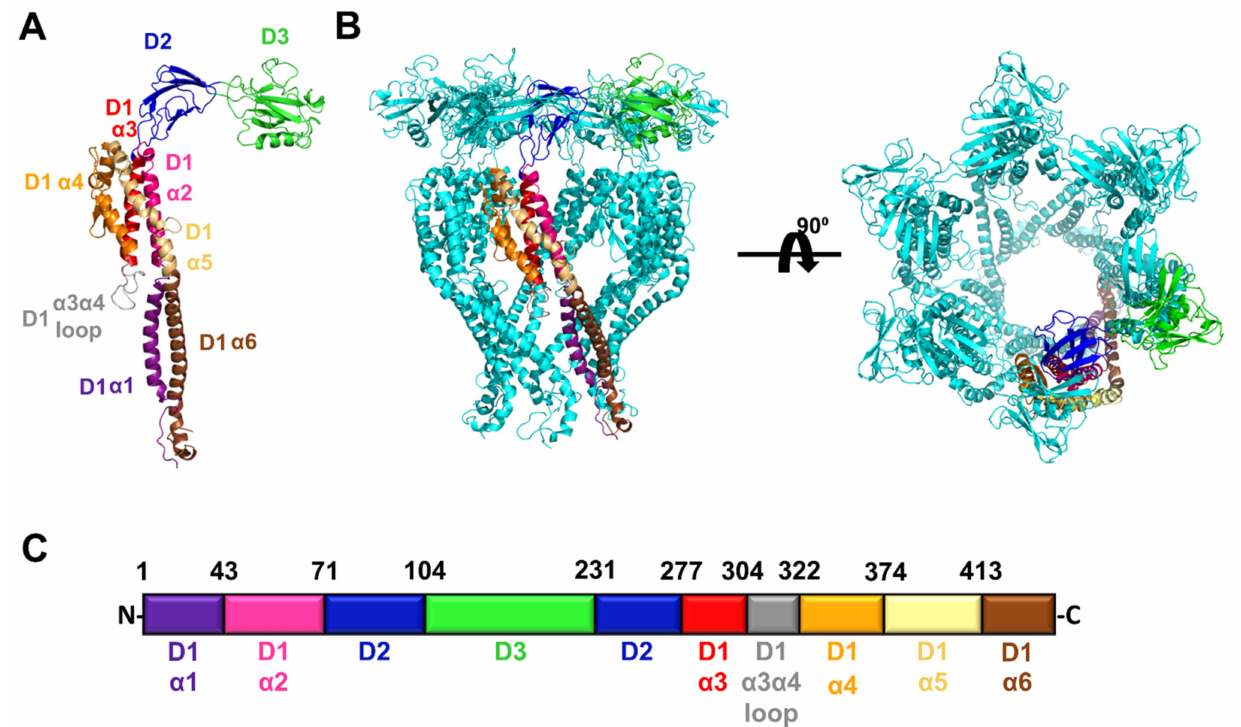
Figure 1. Structural model of full length FliD from the P. aeruginosa PAO1 strain. ( A ) Model of the FliD monomer. The α helices in the D1 domain are individually colored and labeled; domains D2 and D3 are individually colored and labeled. ( B ) Model of the FliD hexamer. A single FliD monomer is colored as in ( A ); the remaining five monomers in the hexamer are in cyan. ( C ) Organization of the P. aeruginosa PAO1 FliD protein. Colors of domains or secondary structural elements within domains correspond to those in ( A ). The N- and C-termini, as well as the amino acid positions at the boundaries between domains or secondary structural elements, are